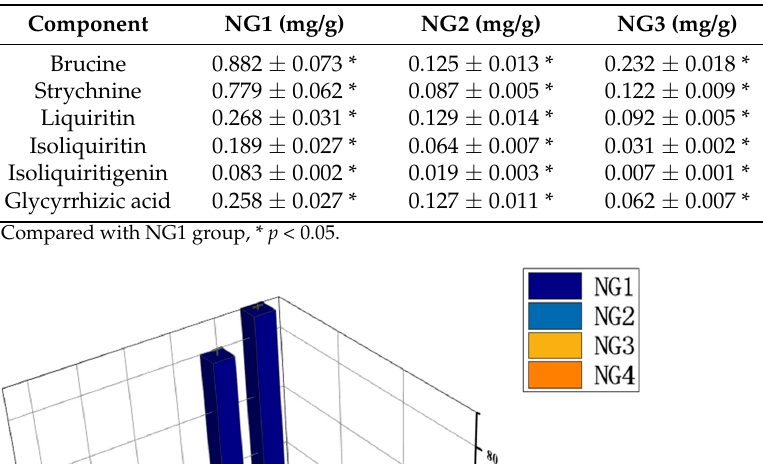
Table 3. Determination of the concentration of each component in different phase states (mean ± SD, %).